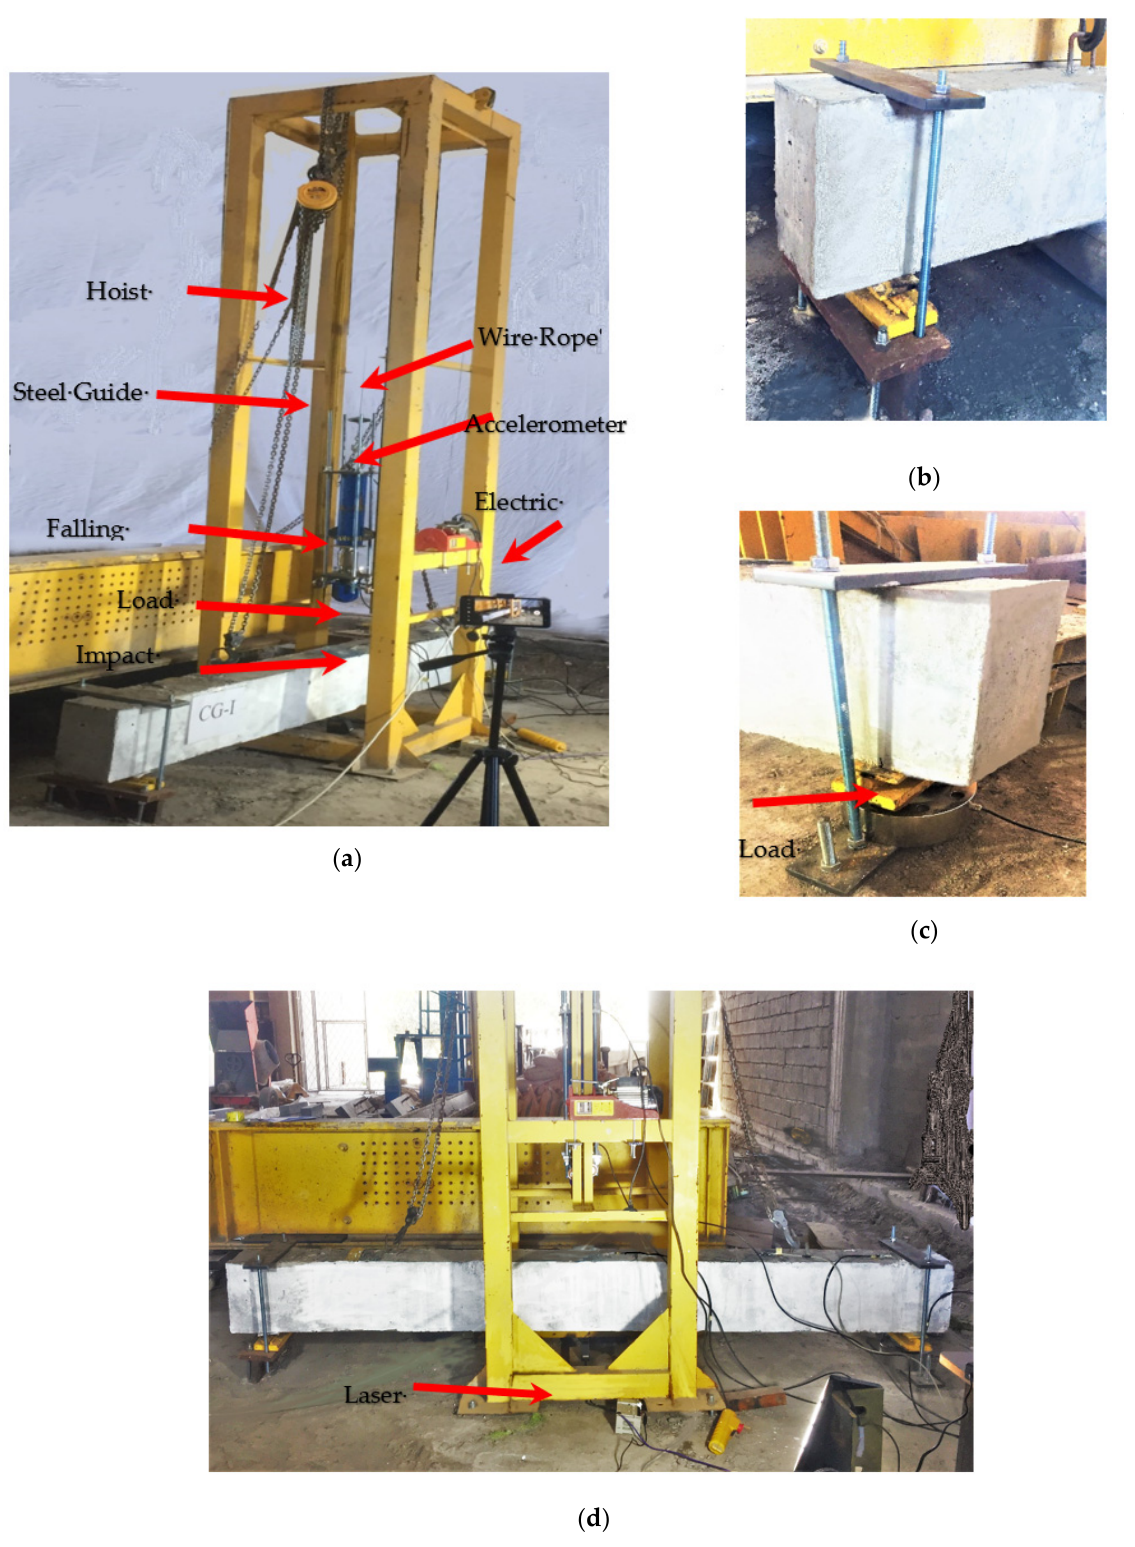
Figure 3. Setup of the impact test: ( a ) Steel frame of the impact test; ( b ) Left support with steel yokes; ( c ) Right support with load cell; ( d ) Front view of the test.